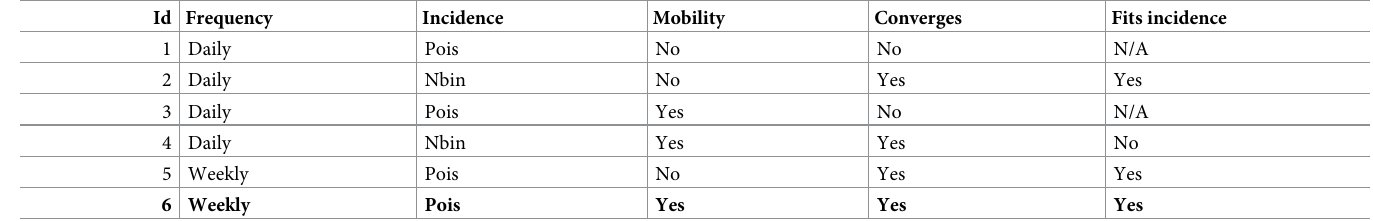
Table 1. Measurement model